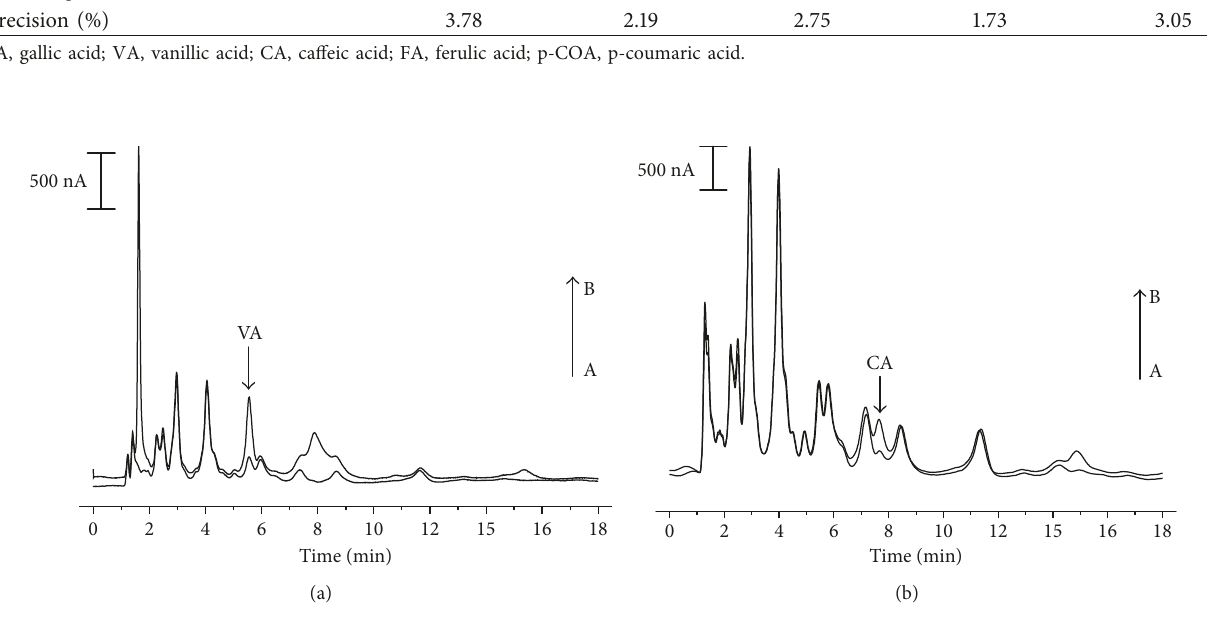
Figure 7: Chromatograms acquired for (a) sugarcane vinasse sample (1: 10 dilution) (A) and sample with standard addition of 25 μ mol (A). (b) Sugarcane vinasse sample (9 :10 dilution) (A) and sample with standard addition of 50 μ mol shown in Figure 4.